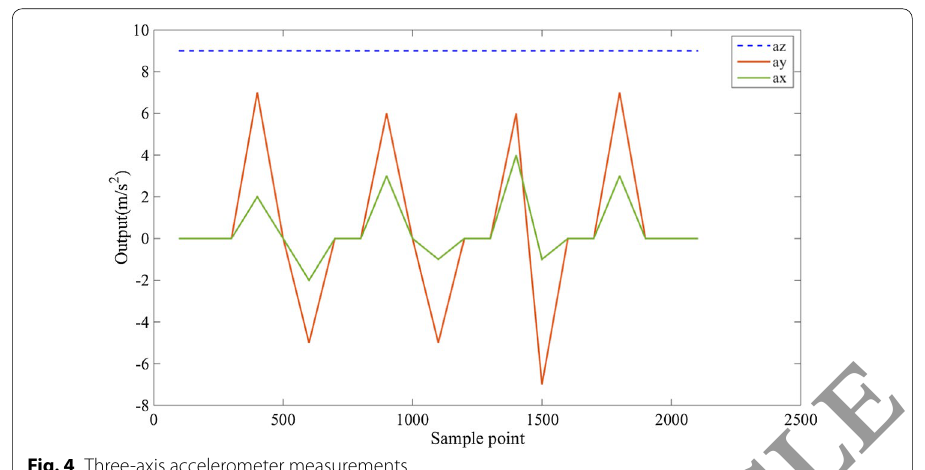
Fig. 4 Three-axis accelerometer